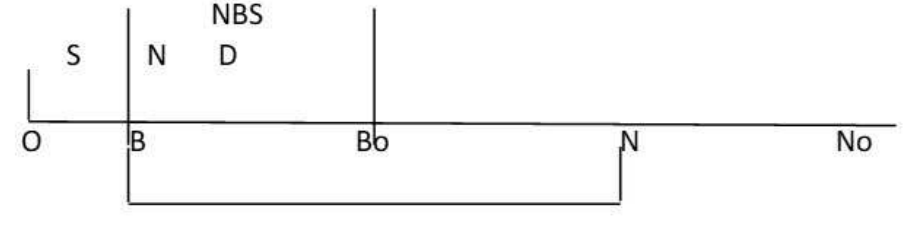
Figure 1. Area of shared and contradictory interests of the relationships based on